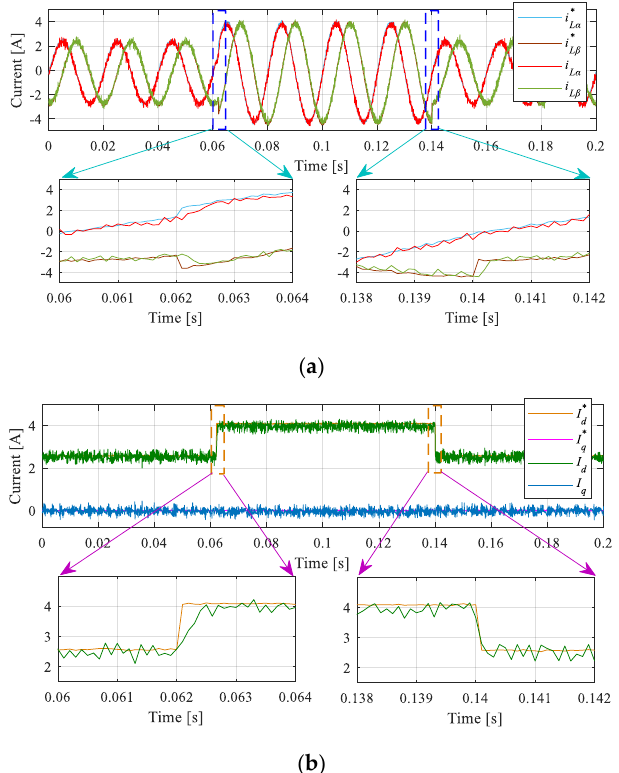
Figure 13. Experimental result: tracking performance of load current for the FS-MPC in ( a ) αβ -frame and ( b ) dq -frame.